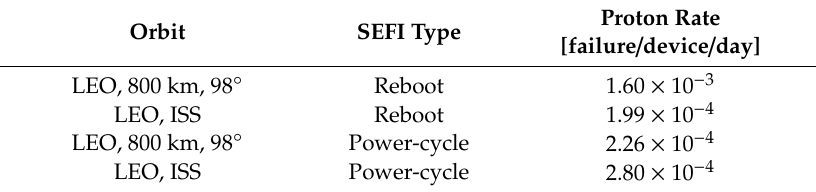
Table 2. Predicted in-orbit rates based on the test results (launch date: 6 June 2019).